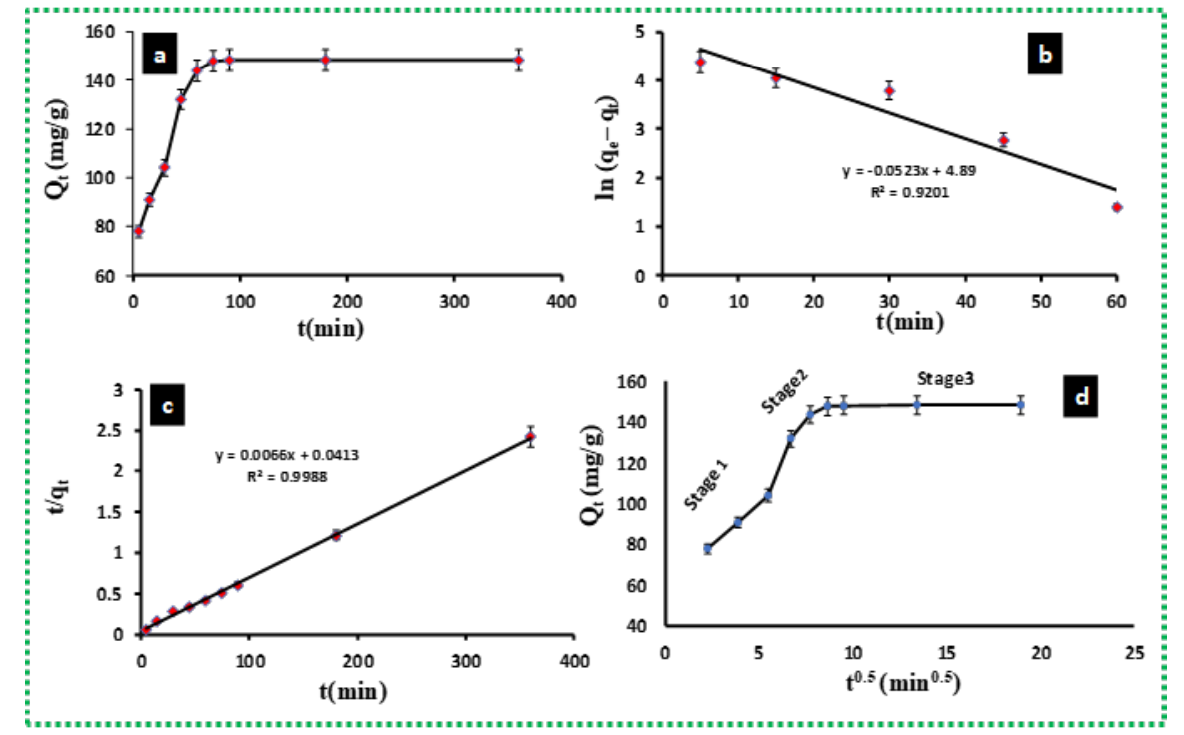
Figure 5. Effect of contact time ( a ), the pseudo-first-order ( b ), the pseudo-second-order ( c ), and intra-particle diffusion ( d ) equations associated with the adsorption of MB on BE/SD – MNPs. Operating conditions: 25 mg of BE/SD – MNPs mass, 25 mL of M.B. solution (150 mg/L), 25 °C of adsorption temperature, and solution pH 8.0.